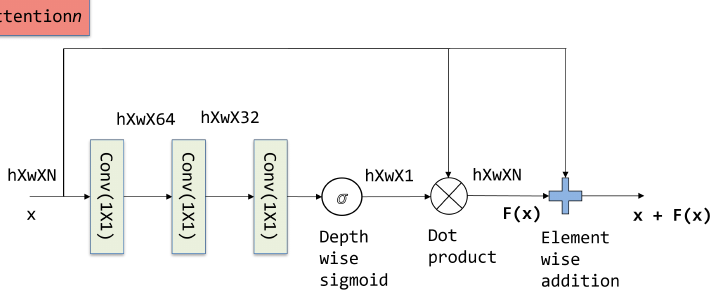
Figure 2. Convolutional structure for the proposed attention block. The dimension of layer outputs is mentioned above the